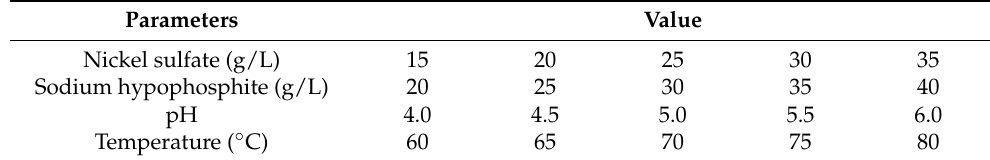
Table 2. Selected parameters in test.